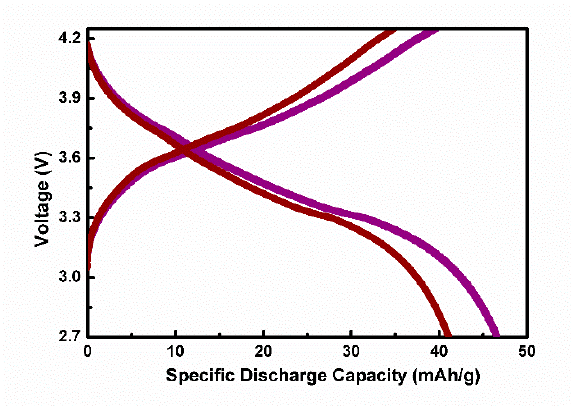
Figure 3. Specific Discharge Capacity (mAh/g) of the B ‐ HT and P ‐ 02 Samples.